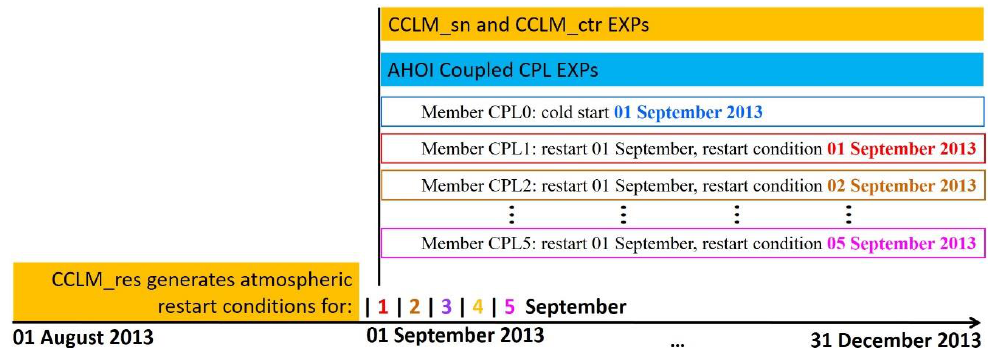
Figure 3. Schematic of spin up and an ensemble generation procedure. The restart strategy is only applied for CCLM in all stand-alone and coupled experiments.